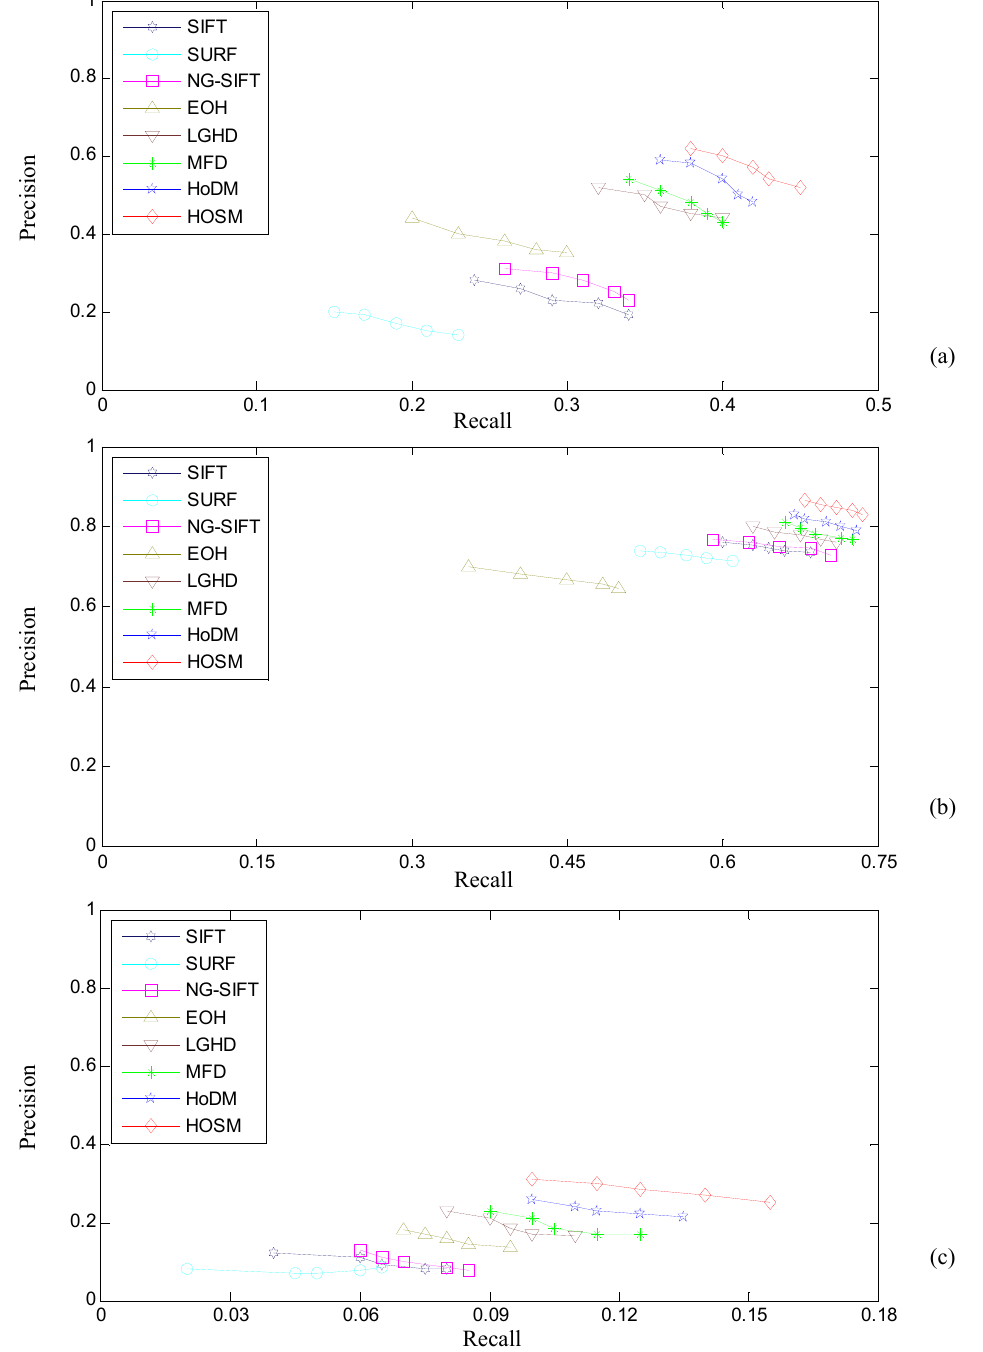
Figure 12. Quantitative comparisons on precision-recall averages with NNDR thresholds from 0.8 to 1.0 in three datasets. ( a ) Potsdam dataset, ( b ) EPFL dataset, and ( c ) CVC dataset.